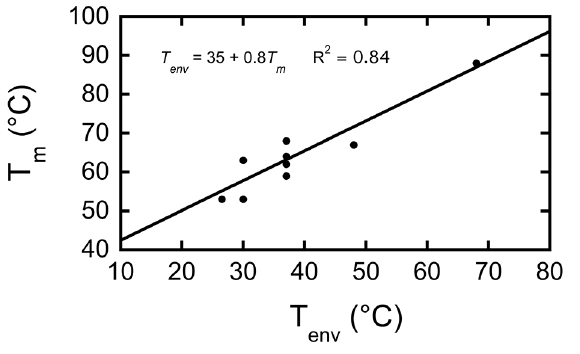
Figure 1. Organismal growth temperatures correlate with thermostability in extant RNH proteins. There is a strong correlation between the melting temperature of RNH and its host organism’s growth temperature, suggesting thermostability is product of environmental selection. See also Table